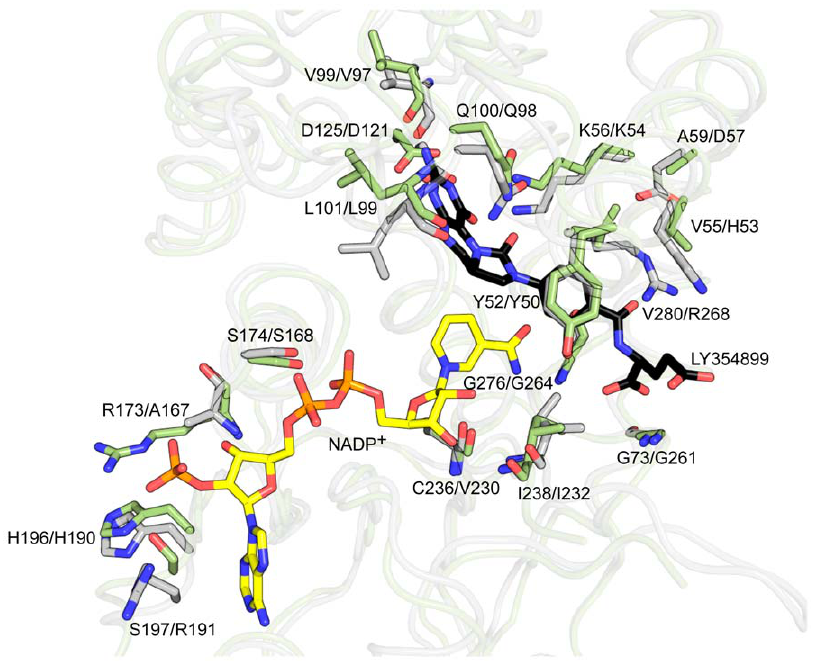
Figure 4. Analysis of active site residues. Superposition of the Hs DHCH (green) - NADP + (yellow) - LY354899 (black) complex (PDB code: 1DIB) onto the remodeled Pa FolD structure (grey). Residues that interact with either NADP + or LY354899 molecules in Hs DHCH and their counterparts in Pa FolD structure are shown as sticks.